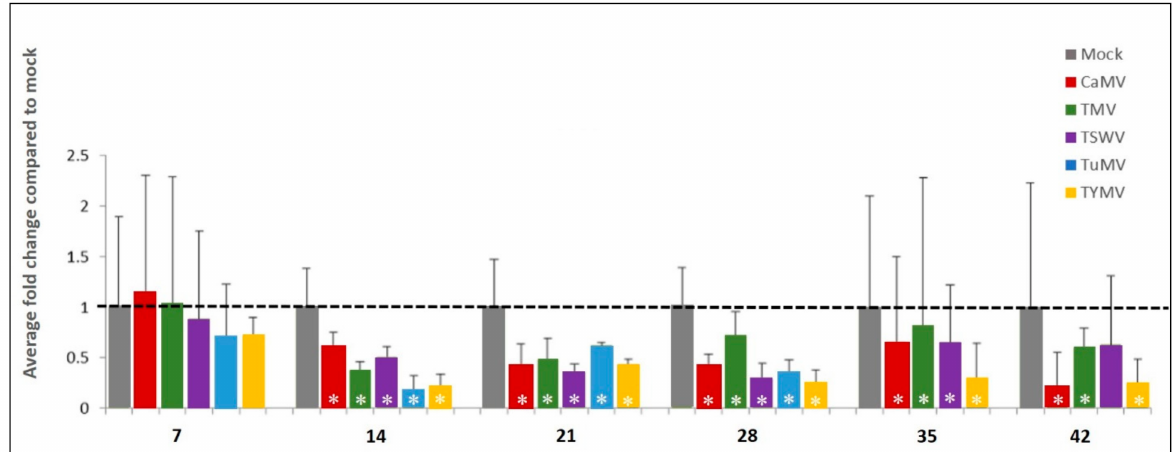
Figure 4. Average fold change of AtSGS3 transcript accumulation in virus infection. Log transformed, mean centred and auto-scaled AtSGS3 transcript accumulation of three biological replicates of mock-inoculated and virus-inoculated plants. Data normalised to the reference gene SAND. Virus- inoculated data were compared to mock-inoculated data of the same days post inoculation (dpi) (7, 14, 21, 28, 35 and 42). Error bars are upper 95% confidence level (+95% CI). Asterisks (*) indicate statistically significant difference to the mock in each time point. CaMV, cauliflower mosaic virus; TMV, tobacco mosaic virus; TSWV, tomato spotted wilt virus; TuMV, turnip mosaic virus; TYMV, turnip yellow mosaic